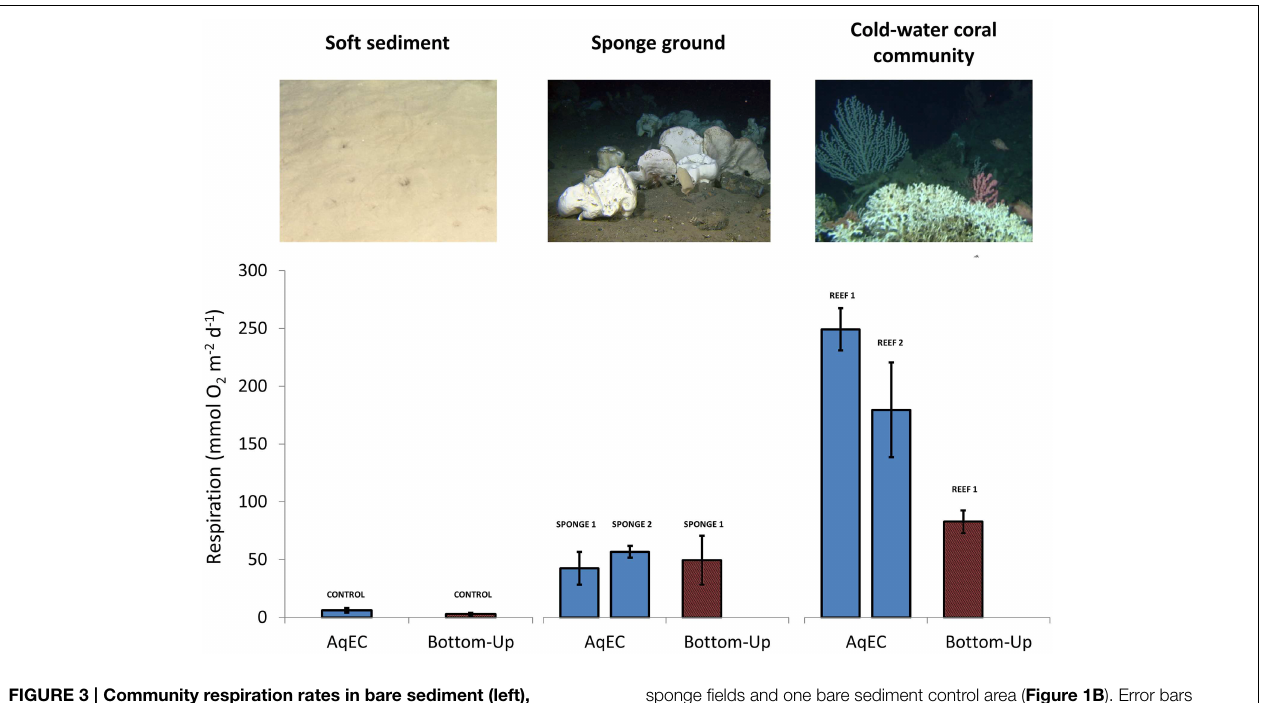
sponge fields and one bare sediment control area ( Figure 1B ). Error bars indicate standard deviations for AqEC fluxes and propagated errors for the bottom-up estimates. Names above the bars indicate where the measurement was